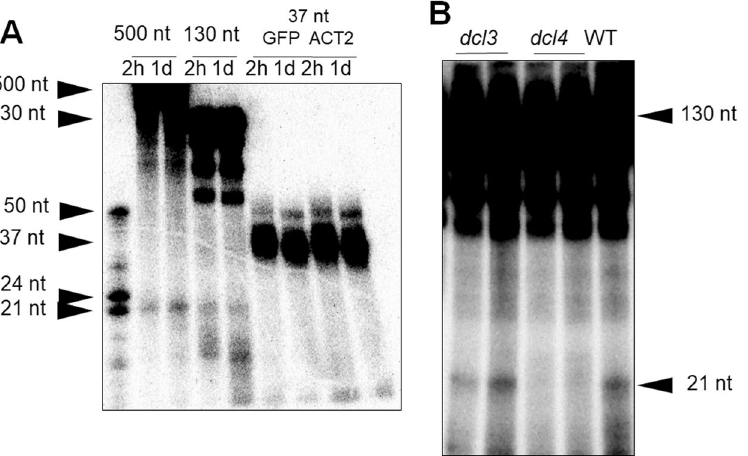
Figure 2. The dsRNA-cleaving activity of DCL4 in Arabidopsis protoplasts. Protoplasts prepared from 2-week- old Arabidopsis seedlings were transfected with 32 P-labeled dsRNAs of 37 nt ( A ), 130 nt ( A , B ), or 500 nt ( A ). Total RNAs were extracted from protoplasts 2 hours ( A ) or 1 day ( A , B ) after transfection, and electrophoresed by denaturing 15% PAGE. Cleaved products were detected by autoradiography. Protoplasts were isolated from WT ( A , B ), dcl3 ( B ), or dcl4 ( B ) seedlings, and the 37-nt dsRNAs ( A ) were synthesized from the ACT2 and GFP genes and dsRNAs of 130 nt and 500 nt were synthesized from the GFP gene. Two biological replicates are shown for lanes dcl3 and dcl4 in ( B